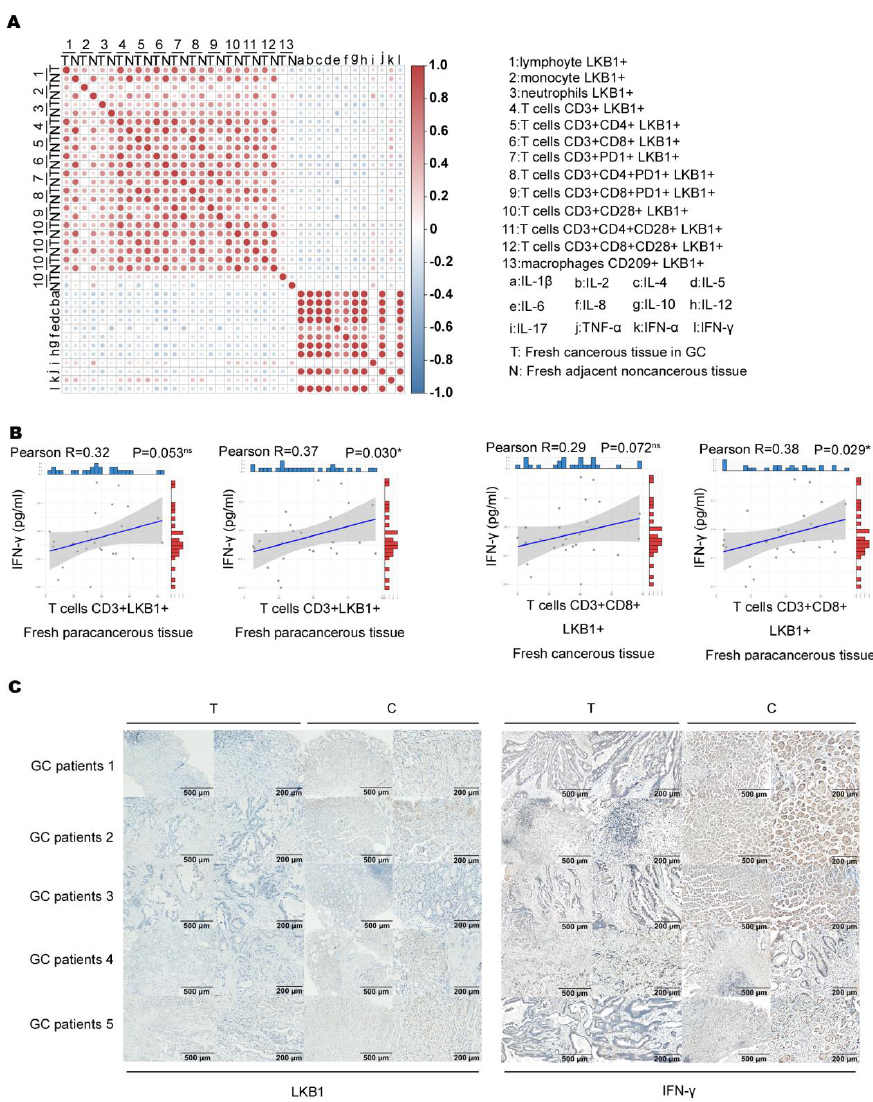
Figure 4. LKB1 positively correlated with IFN −γ expression. ( A ) Analysis of the association between immune cell infiltrate (LKB1+) proportion and cytokine expression. ( B ) Correlation of T cell (CD3+LKB1+) and (CD3+CD8+LKB1+) proportions with IFN −γ expression in fresh cancerous (T) and adjacent non−cancerous tissues (N). ( C ) Immunohistochemical analyses of LKB1 and IFN −γ expression in fresh cancerous (T) and adjacent non-cancerous tissues (N).